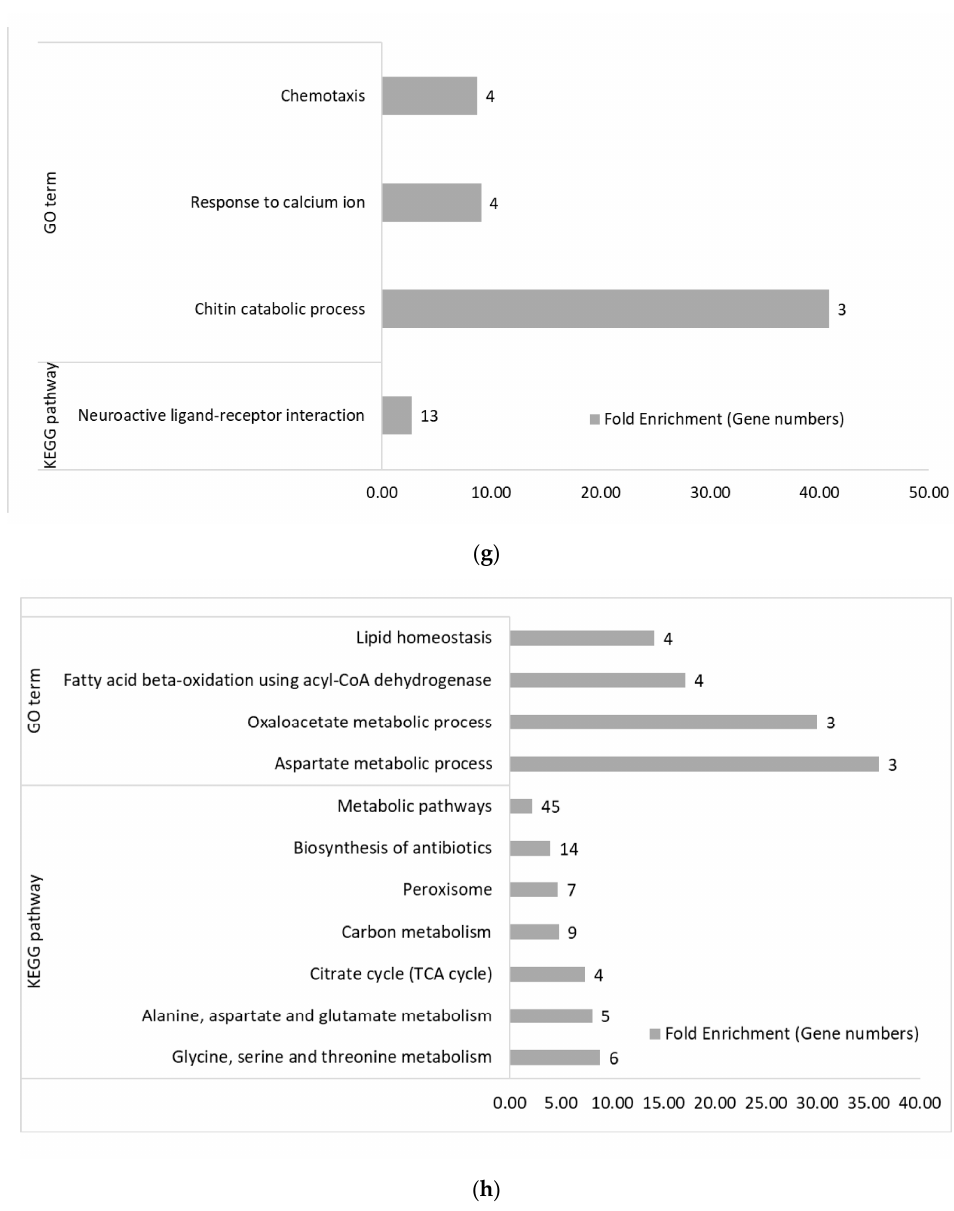
Figure 6. Gene ontology (GO) biological processes and KEGG pathway overrepresentation ( p < 0.05, fold enrichment > 2 and FDR < 0.2) for between-line comparisons. ( a ) GO terms and KEGG pathways significantly enriched by Fayoumi-biased genes in the FCLC comparison at AH. ( b ) GO terms and KEGG pathways significantly enriched by Leghorn-biased genes in the FCLC comparison at AH. ( c ) GO terms and KEGG pathways significantly enriched by Fayoumi-biased genes in the FTLT comparison at AH. ( d ) KEGG pathways significantly enriched by Leghorn-biased genes in the FTLT comparison at AH. ( e ) GO terms and KEGG pathways significantly enriched by Fayoumi-biased genes in the FCLC comparison at CH&NDV. ( f ) GO terms and KEGG pathways significantly enriched by Leghorn-biased genes in the FCLC comparison at CH&NDV. ( g ) GO terms and KEGG pathways significantly enriched by Fayoumi-biased genes in the FTLT comparison at CH&NDV. ( h ) GO terms and KEGG pathways significantly enriched by Leghorn-biased genes in the FTLT comparison at CH&NDV.